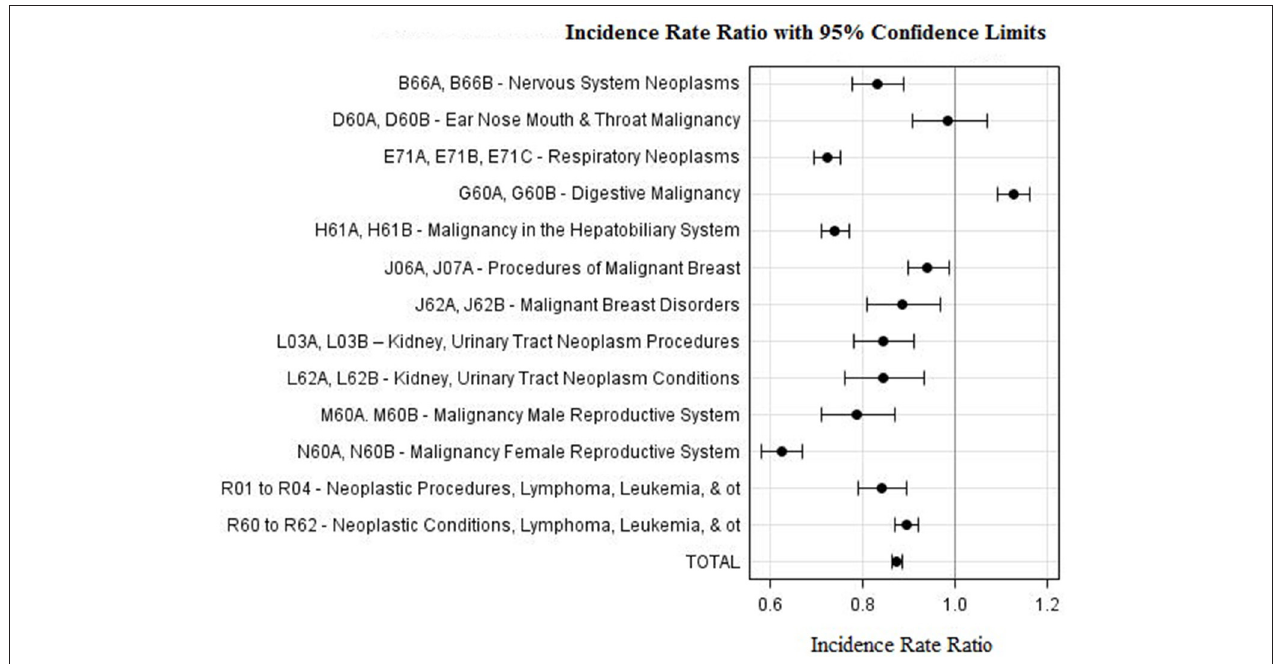
FIGURE 4 | Incidence Rate Ratio Cancer and Neoplasm related DRGs during 2020 as compared to period